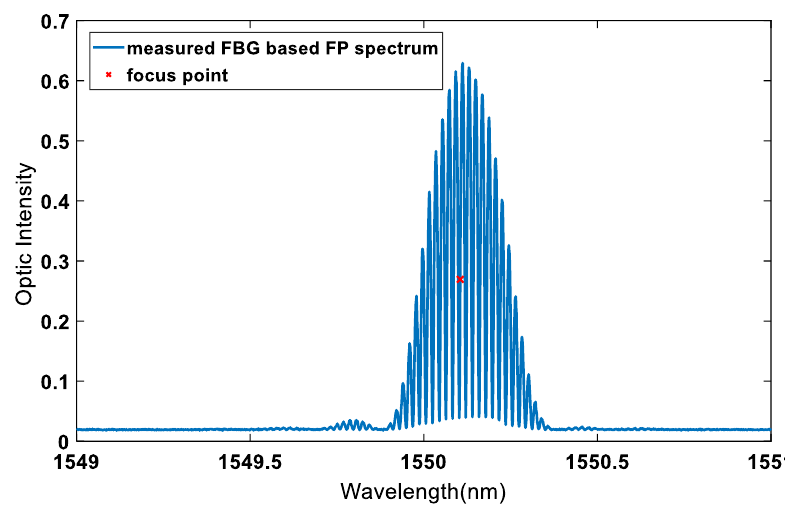
Figure 12. The FBG-based FP spectrum and the focus point for strain measurement.